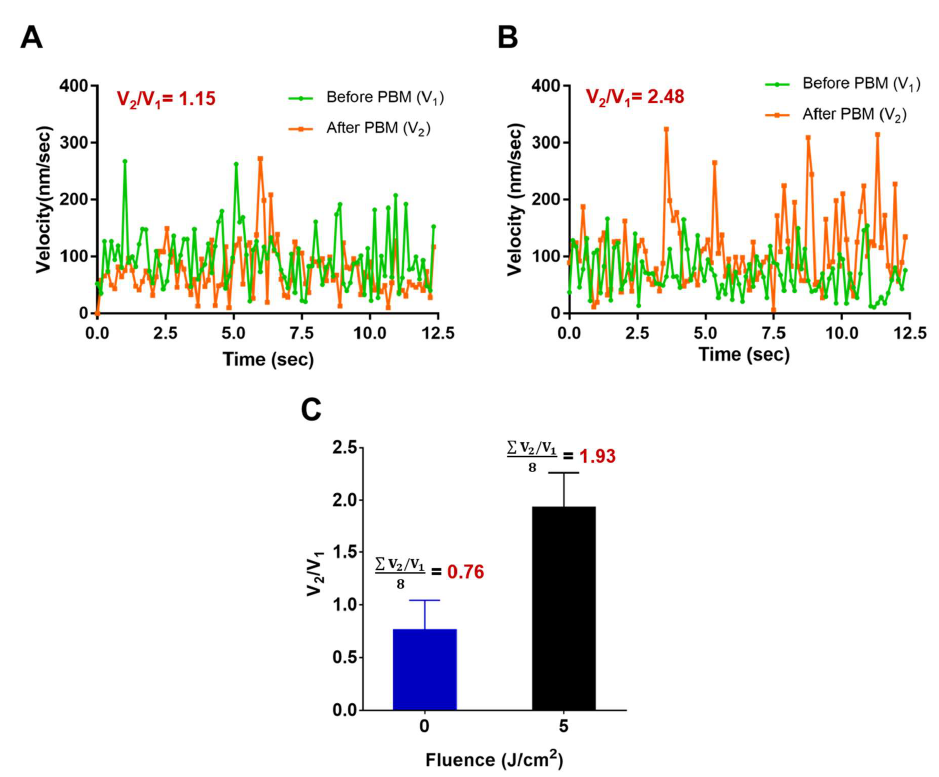
Figure 10. Effects of PBM in vesicle transport on hADSCs. Values were expressed as the velocity’s ratio of vesicle transport before (V 1 ) and after PBM (V 2 ) according to time (V 2 /V 1 ± SEM). ( A ) The velocity of the control group (0 J/cm 2 ); ( B ) treatment group (5 J/cm 2 ) at single-cell level. ( C ) Vesicle transport in the irradiated-hADSCs ( n = 8) after 30 min PBM between control group of 0 J/cm 2 and PBM group of 5 J/cm 2 . The ensemble average of the velocity ratio (V 2 /V 1 ) for the control and PBM groups were 0.76 and 1.93, respectively ( p -value = 0.0117).